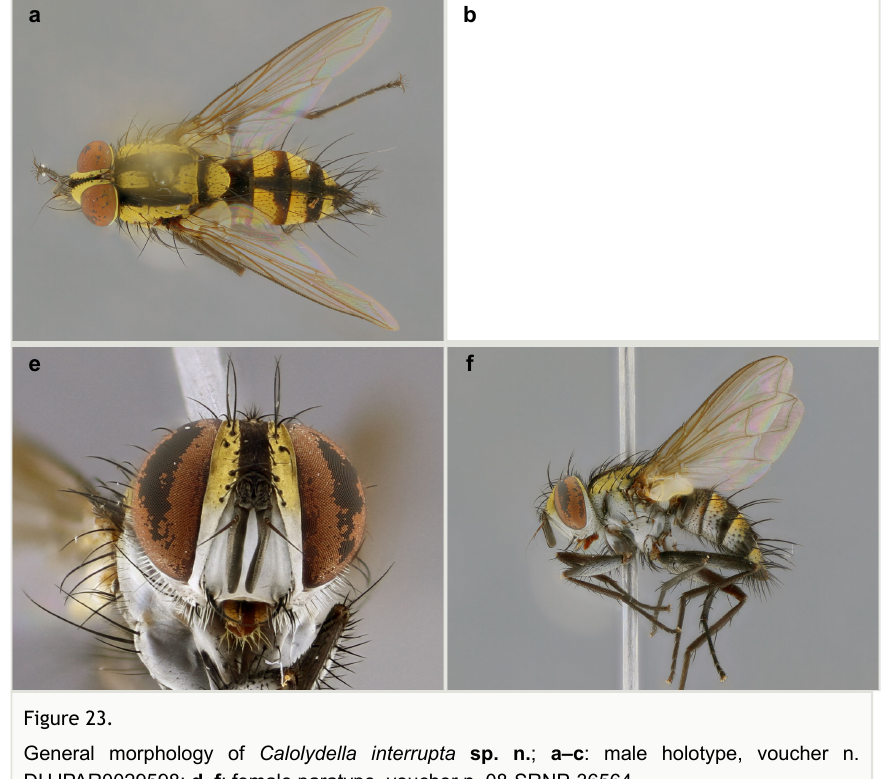
crossvein R-M. Abdomen (Fig. 23a): ground color dark orange, with a median dark stripe breaking up pollinose marginal banding; abdominal pollinosity gold dorsally, silver ventrally; base of ST1+2 black lateroventrally, mostly gold pollinose dorsally; T3 with a row of marginal setae and one pair of discal setae; T4 with one pair of discal setae. Terminalia : not examined.